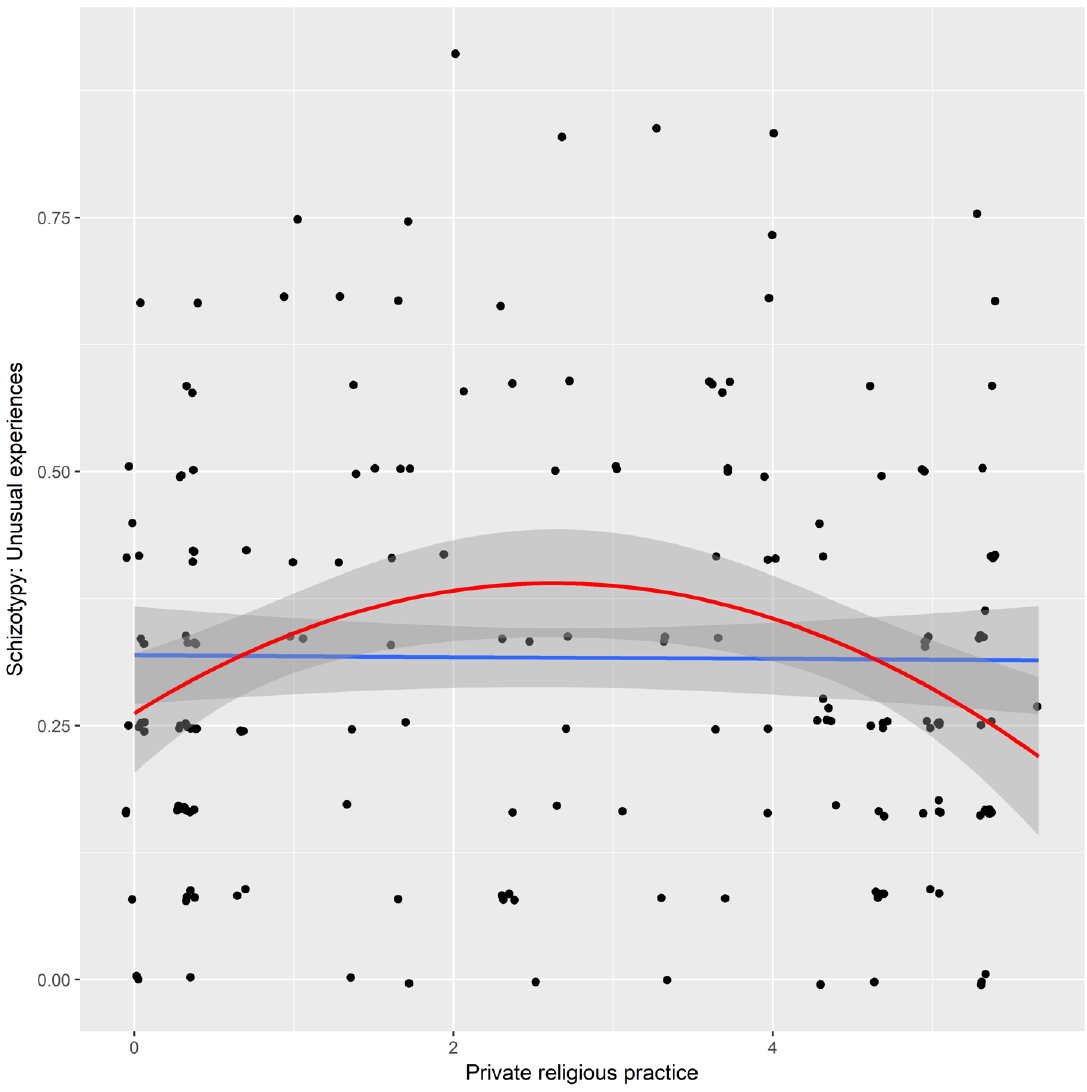
Figure 1. Scatterplot with linear (blue line) and quadratic (red line) trend lines. The grey areas around the lines represent the 95% confidence interval.